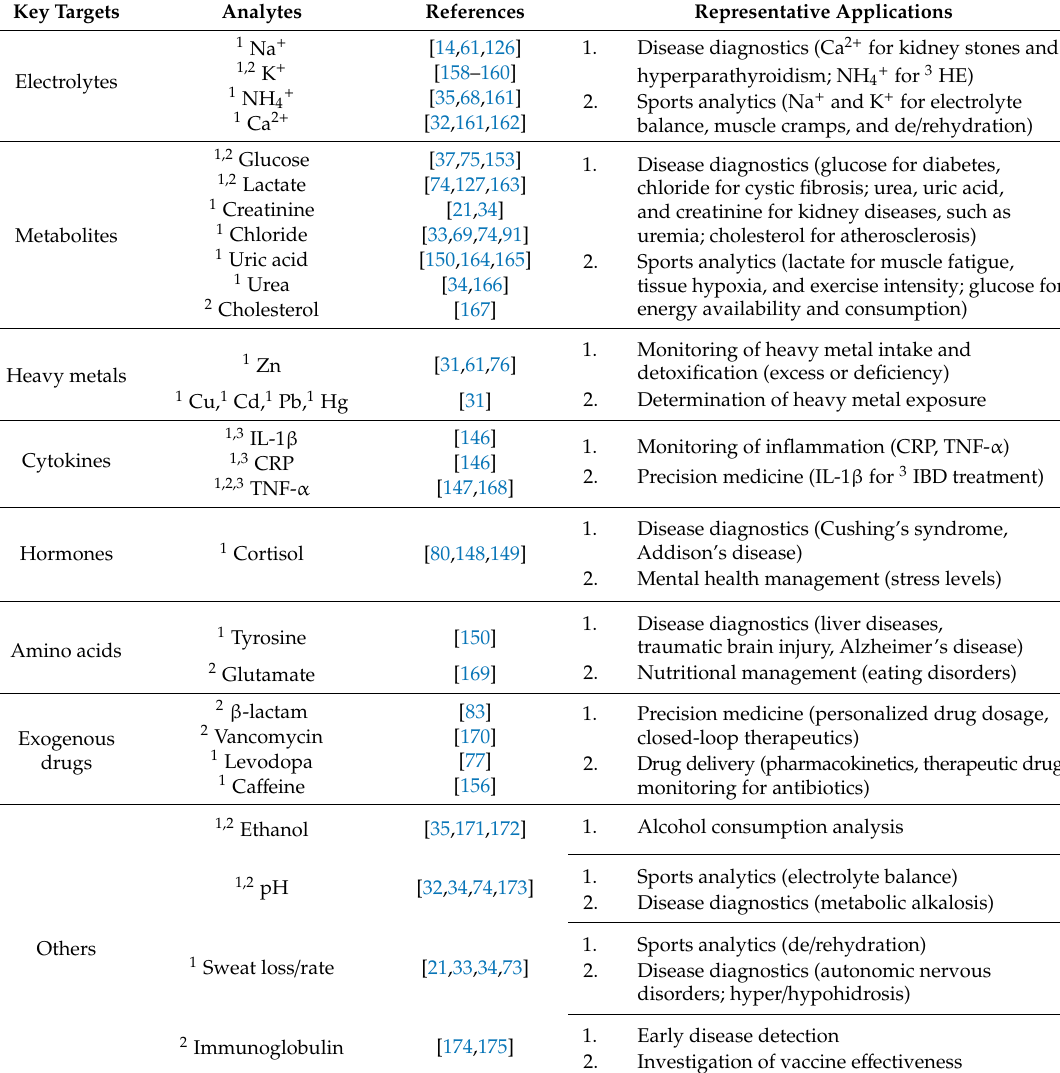
Table 1. Key sweat and ISF analytes in wearable healthcare and sports